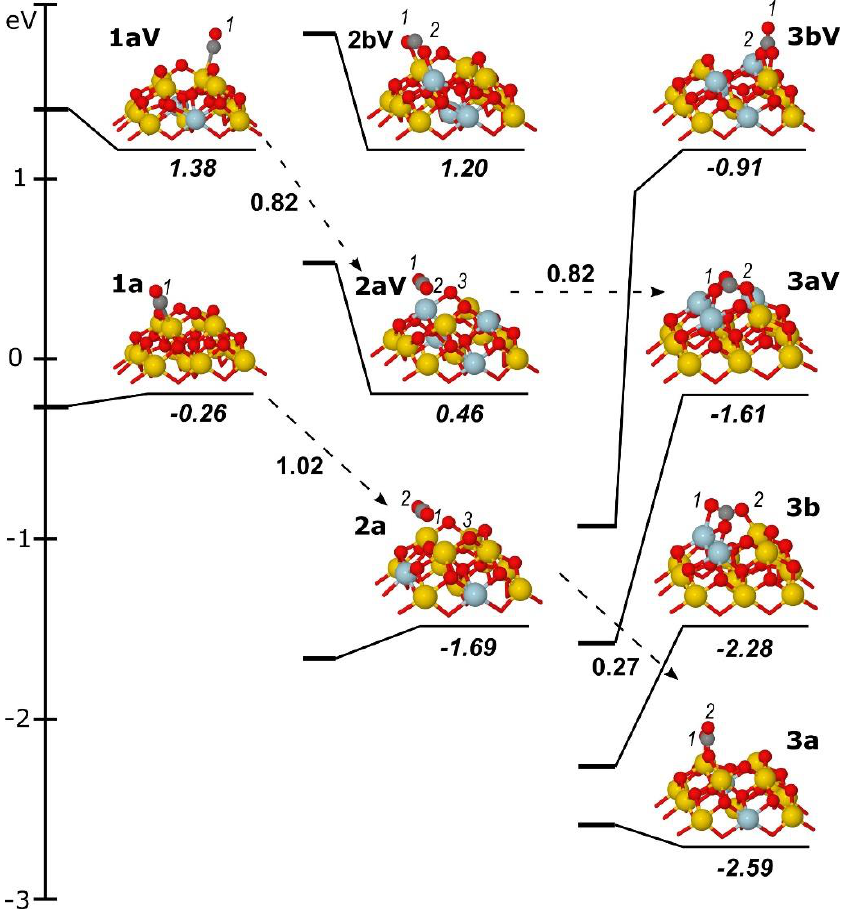
Figure 2. Structures and formation energies E f (in eV) of the complexes created by the interaction of CO with the Ce 21 O 42−n sites (n = 0, 1): CO/Ce 21 O 42 ( 1a ), CO/Ce 21 O 41 ( 1aV ), CO 2 /Ce 21 O 41 ( 2a ), CO 2 /Ce 21 O 40 ( 2aV, 2bV ), CO 3 /Ce 21 O 40 ( 3a, 3b ) and CO 3 /Ce 21 O 39 ( 3aV, 3bV ). Activation energies (E ≠ ) of selected transition states are shown near the dashed arrows connecting corresponding initial reagent and product. The C atoms are shown in dark grey. O atoms numbered with “1”, “2”, and “3” enter CO, CO 2 , and CO 3 moieties, respectively. For further explanations, refer to the main text and the Figure 1 caption.